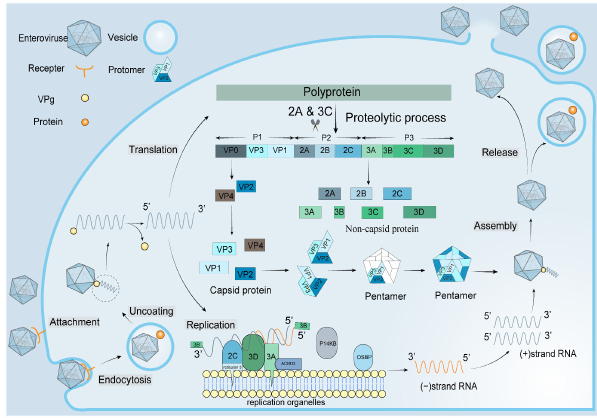
Figure 1. Schematic overview of EV life